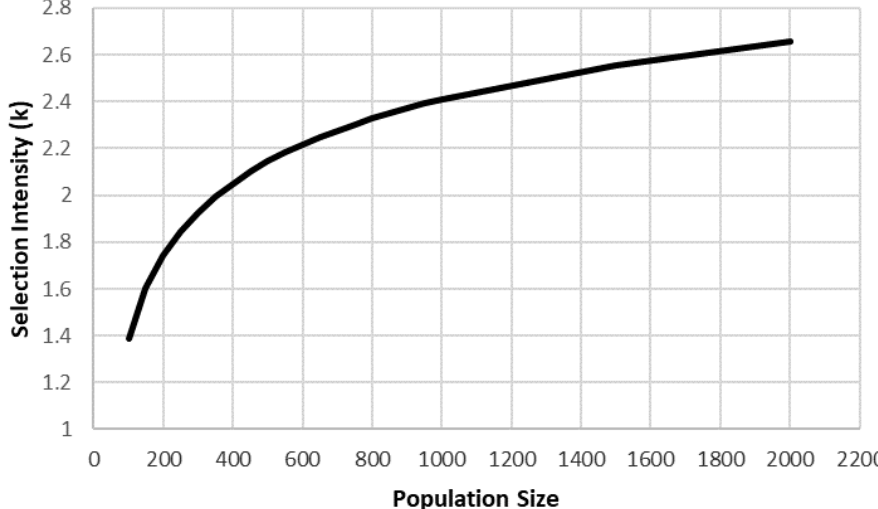
Figure 2. Selection intensity with increasing population size when selecting 20 lines to be parents.